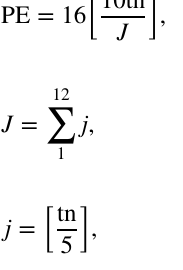
of meteorological stations in Iraq (Al-Sudani 2019a)